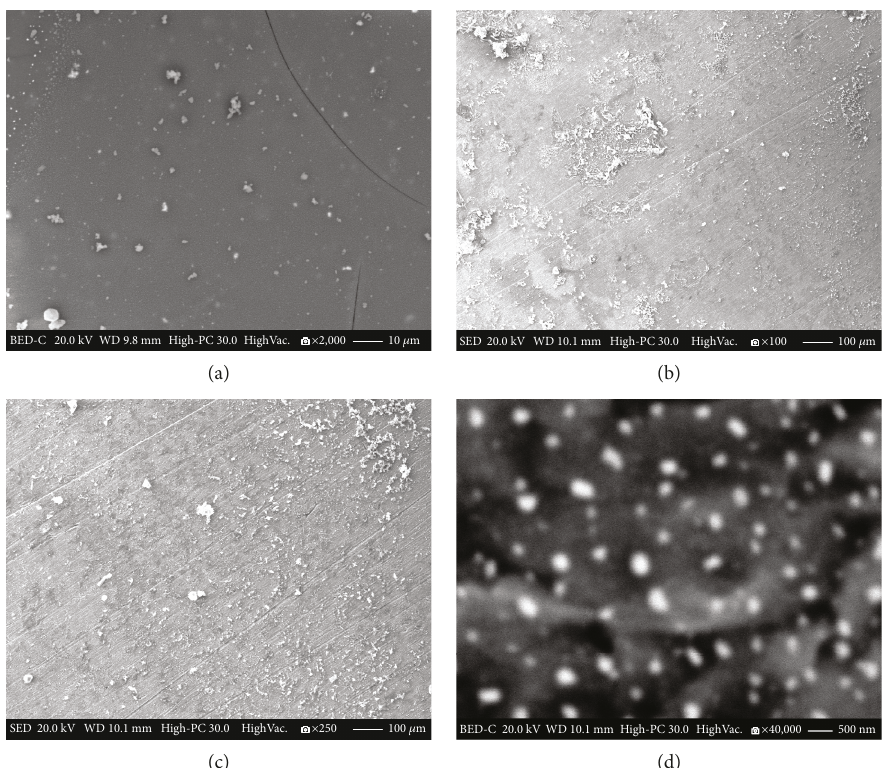
Figure 19: Morphological aspects of carbon steel coated with a fi lm of chitosan doped with 500ppm of nanoparticles, after 24 hours of immersion in a 3.5% NaCl solution at room